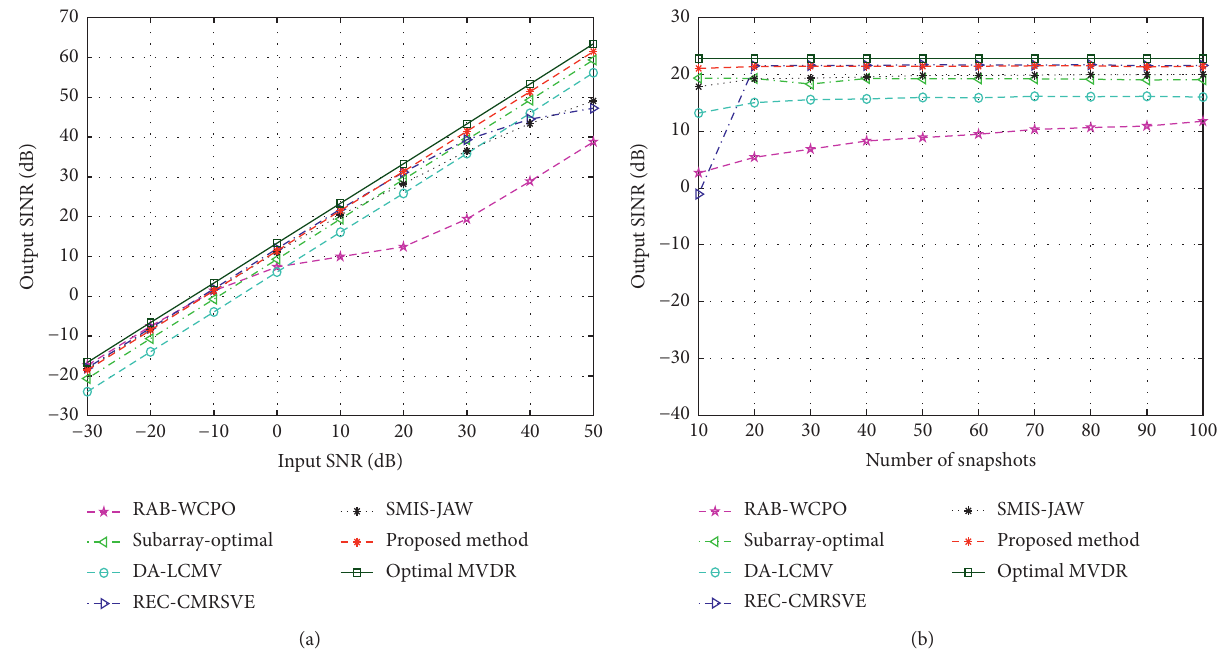
Figure 9: Sixth example: (a) output SINR versus input SNR and (b) output SINR versus number of